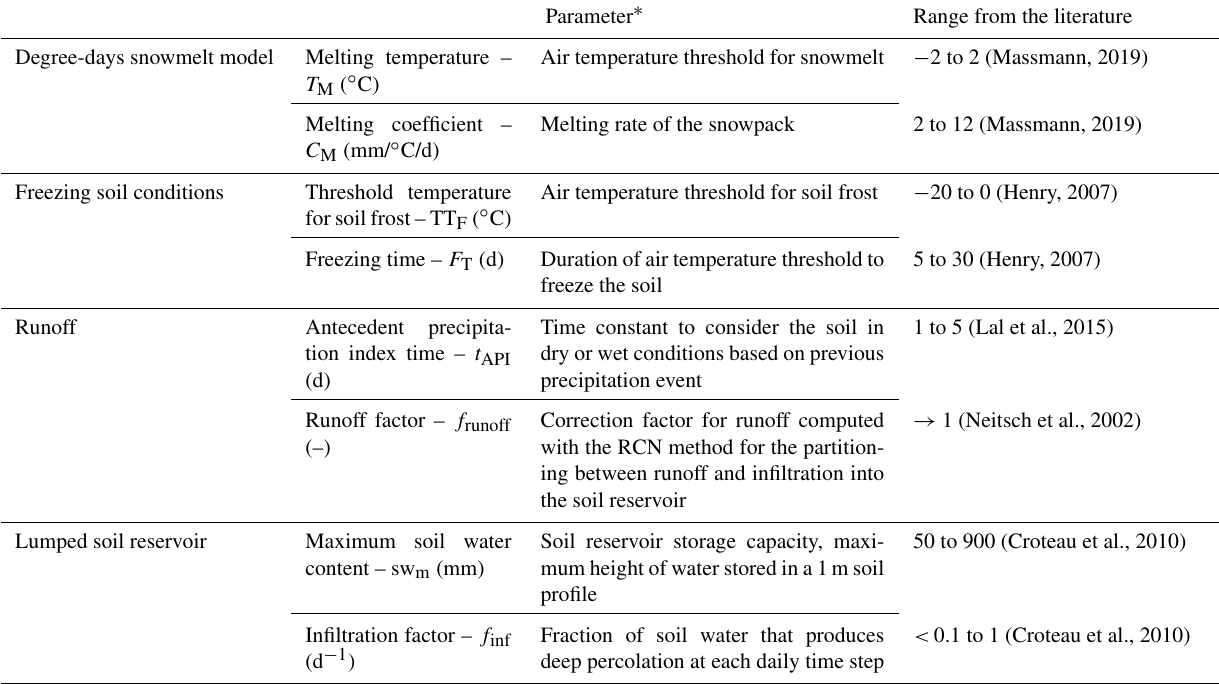
Table 2. Description of the eight HydroBudget